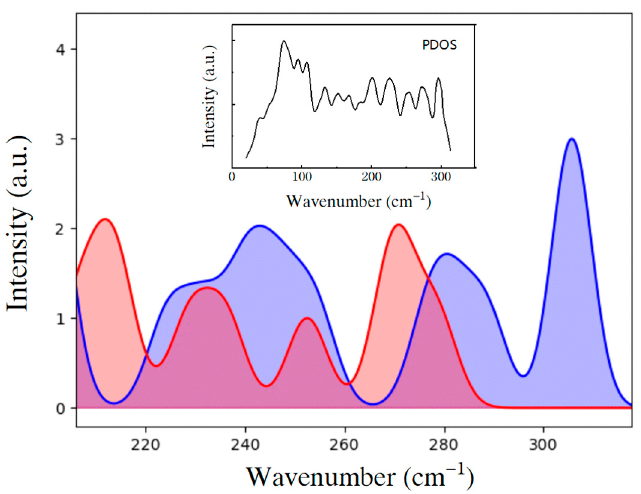
Figure 2. Fitted distribution curves of the four-bond modes (blue) and two-bond modes (red) of ice III from 200 cm − 1 to 320 cm − 1 . The inset is the overall PDOS curve in the translation band.